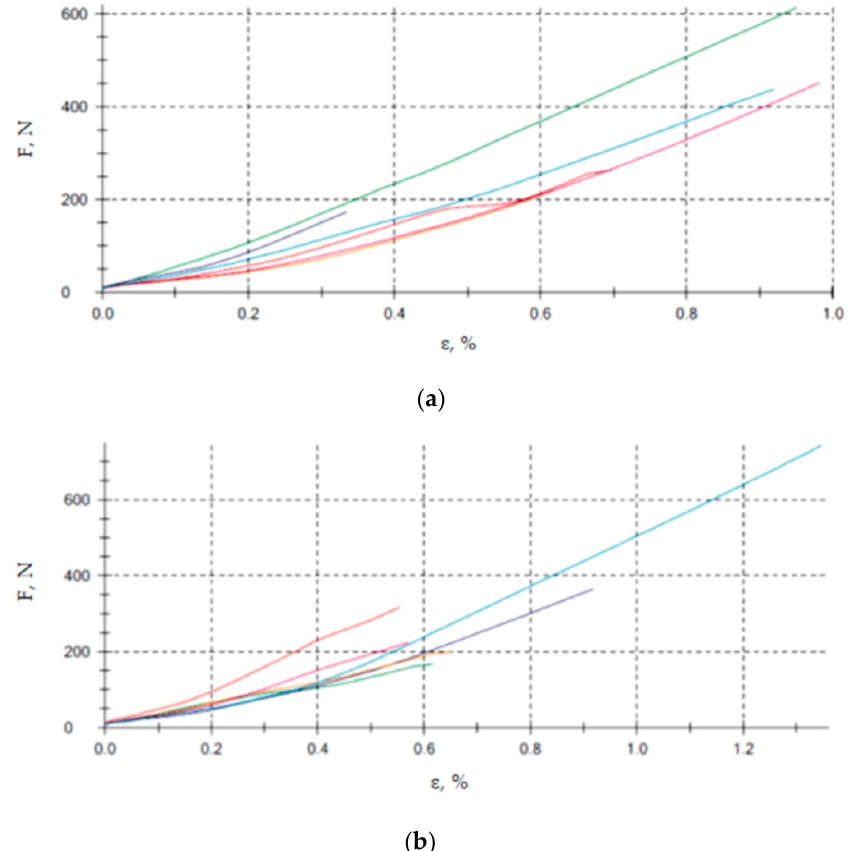
Figure 9. Force–strain curves of the adhesive joints of the polypropylene pipes (PP-25) made with: ( a ) Loctite 3430 A&B Hysol adhesive and ( b ) Loctite 406 adhesive: F—force, ε